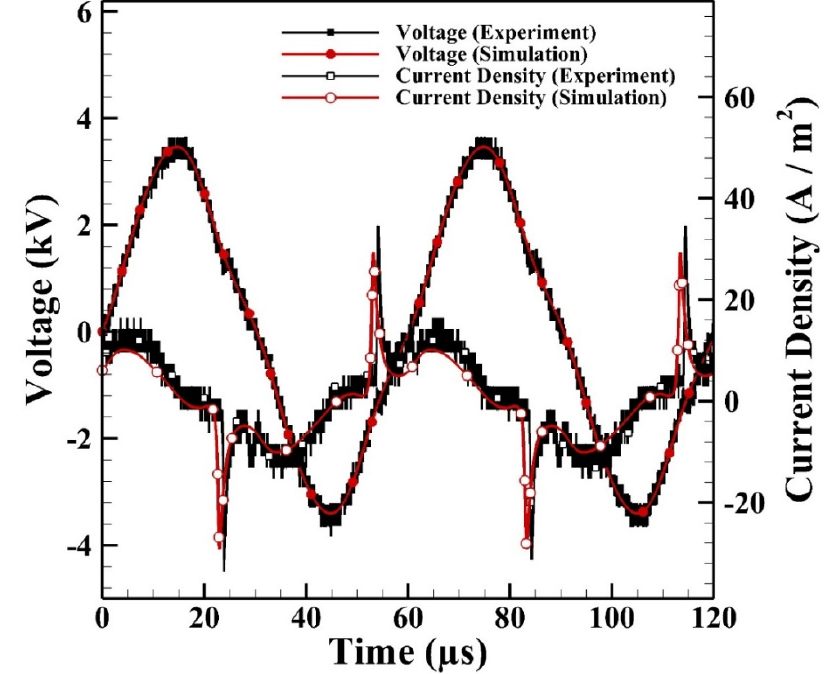
Figure 6. The simulated and measured current densities of atmospheric-pressure helium dielectric-barrier discharges (APHeDBDs) generated in the planar